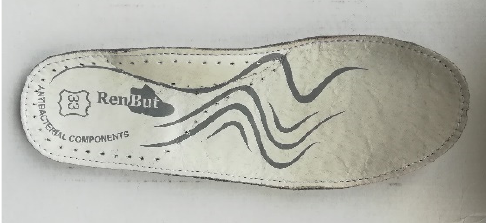
Figure 19. The antibacterial leather insert.